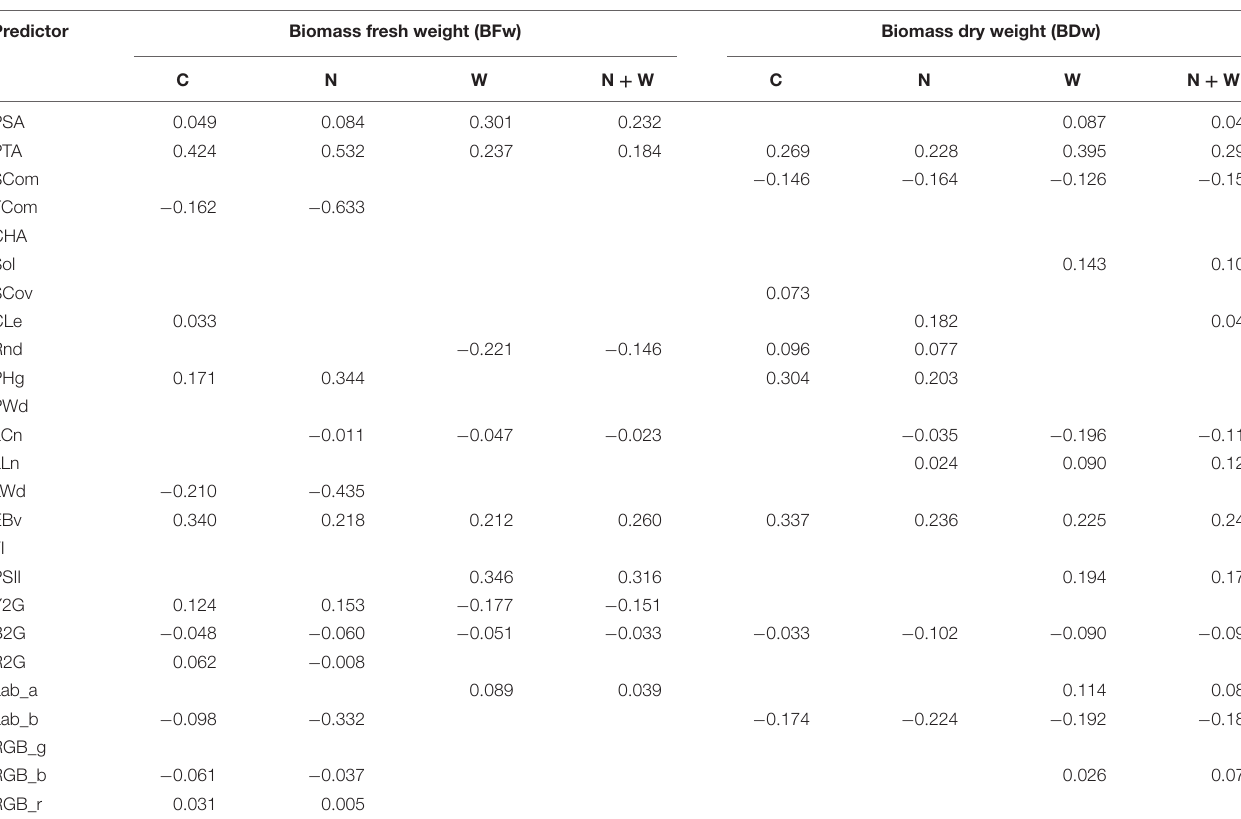
TABLE 2 | Estimated coefficients from the LASSO applied to the biomass fresh and dry weight.